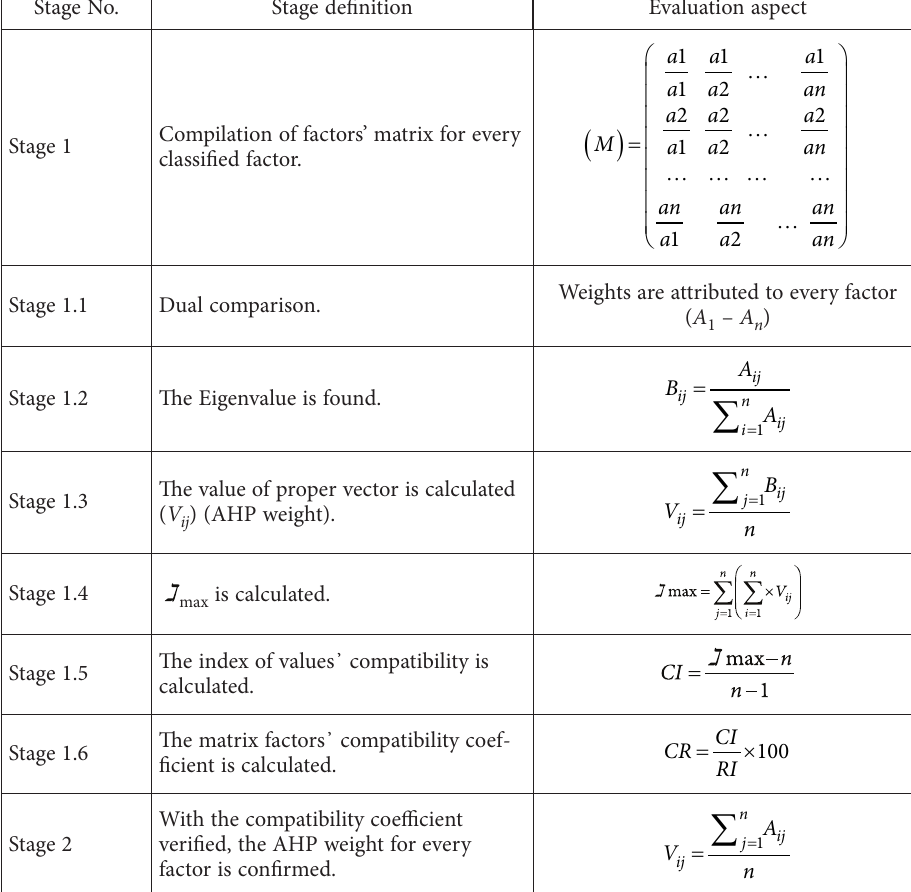
Table 5. Stages of multiple criteria evaluation (created by the authors) Stage